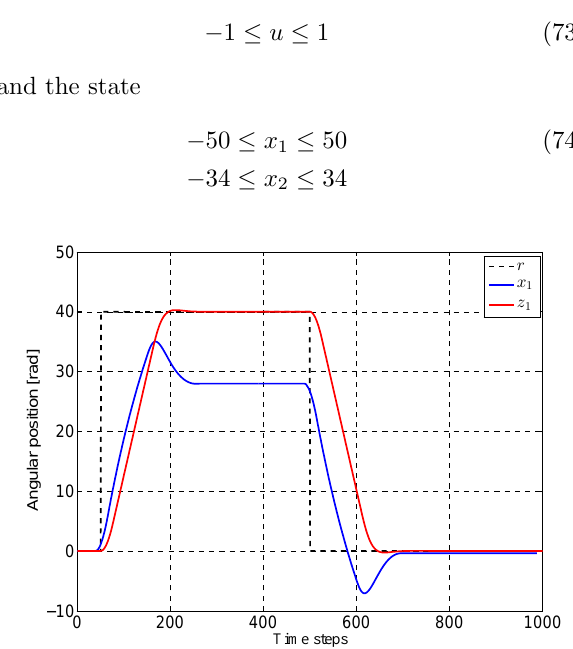
Figure 3: The angular position z 1 of the nominal model, and x 1 of the real plant for the nom- inal MPC